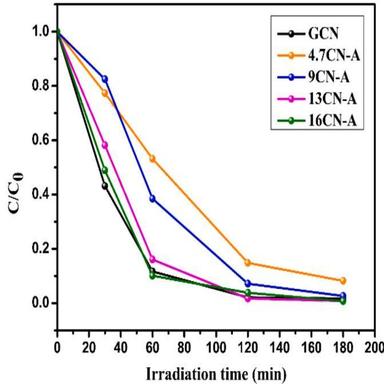
Photodegradation activity of CN-A and g-C3N4 samples with various loadings: (a) g-C3N4; (b) Al2O3; (c) 4.7CN-A; (d) 9N-A; (e) 13CN-A; (f) 16CN-A.